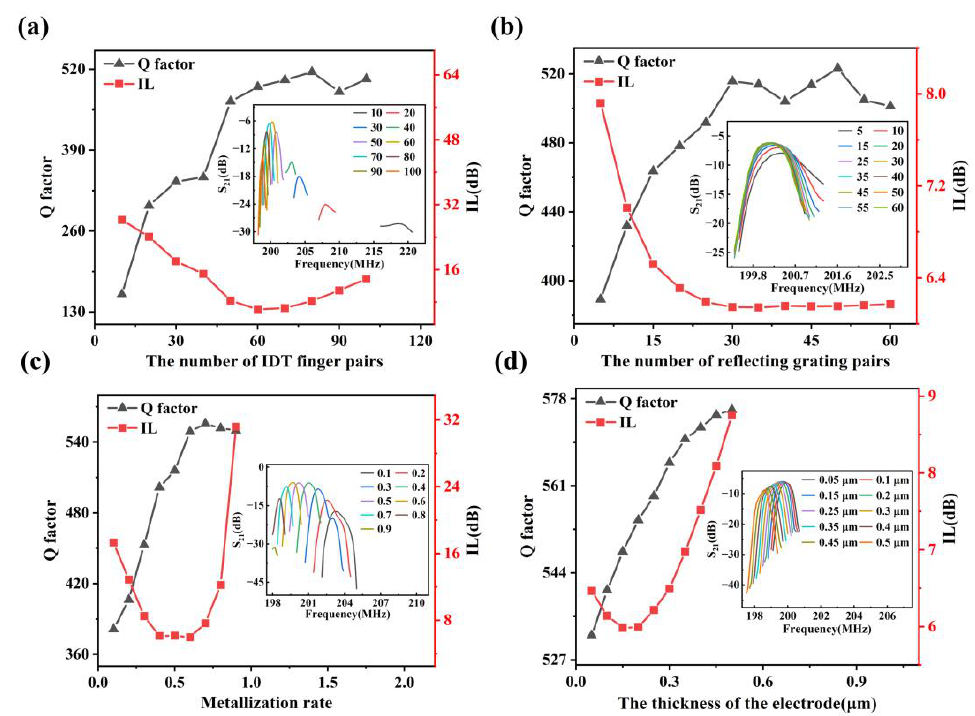
Figure 7. The variation curves of IL and Q of RSAW with respect to the structural parameters of the resonator, where the insets show the resonant peaks of the Rayleigh mode. ( a ) The number of IDT finger pairs. ( b ) The number of reflecting grating pairs. ( c ) Metallization rate. ( d ) The thickness of the electrode.